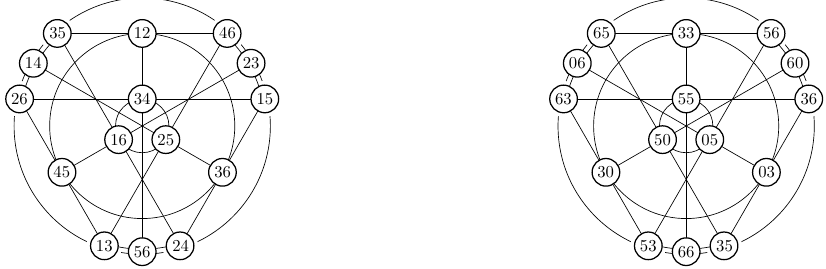
Figure 1. A pictorial representation of the doily, with its points labeled by duads ( left ) and non-unimodular vectors ( right ); both a duad { a , b } and a vector ( a , b ) are abbreviated to ab .